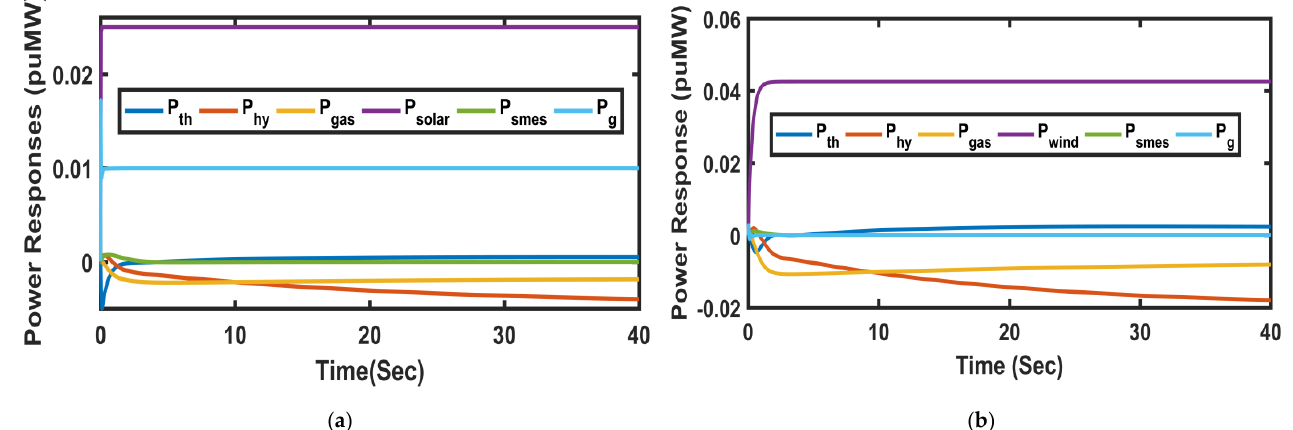
Figure 7. Power responses of various sources of ( a ) area-1 and ( b ) area-2. Figure 6. Power responses of various sources of ( a ) area-1 and ( b ) area-2.